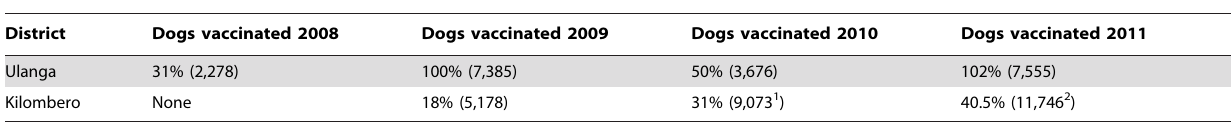
Table 1. Official vaccination